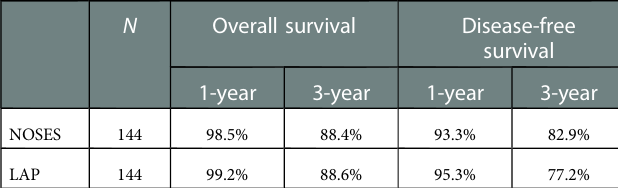
TABLE 3 Overall survival and disease-free survival of patients in NOSES group and LAP group. N Overall